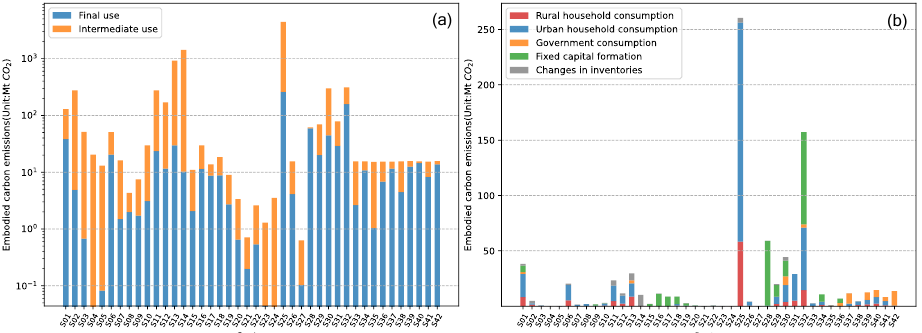
Figure 3. Embodied carbon emissions by sector in China. ( a ) The scale of embodied CO 2 emissions from intermediate use and final use in each sector. ( b ) The scale of embodied CO 2 emissions from different categories of final use in each